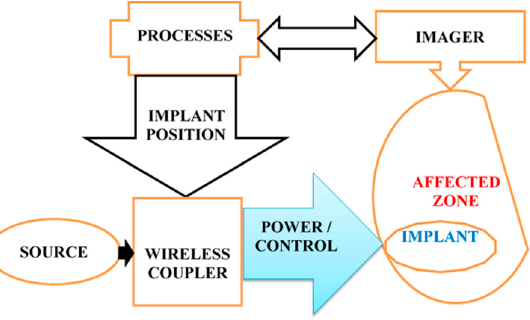
Figure 1. Collaborative simultaneous self-ruling image guided drug release system.